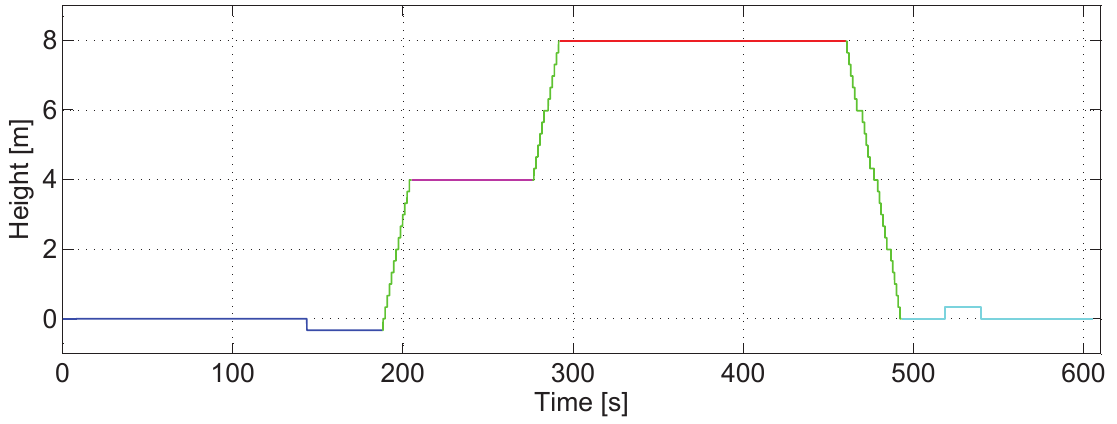
Figure 13. Height estimation of the walk shown in Figure 12 recorded at the Deutsches Museum, Munich (Germany).